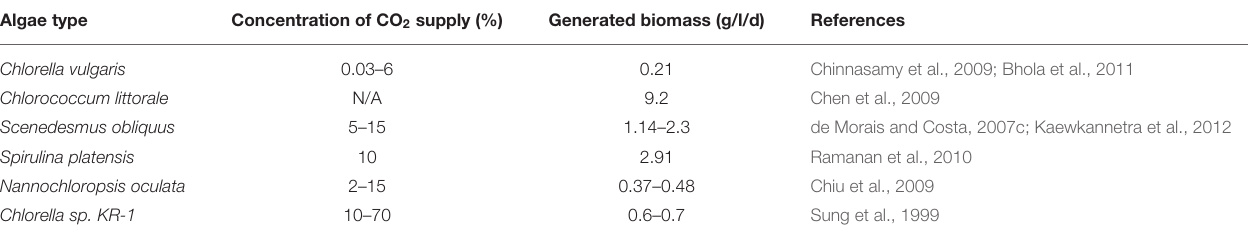
TABLE 4 | Generation of biomass by pure microalgae cultures at specific CO 2